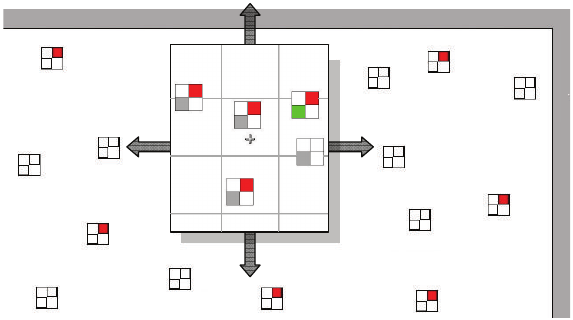
Figure 3: Halos indicate o ff -screen objects. Red halos indicate target